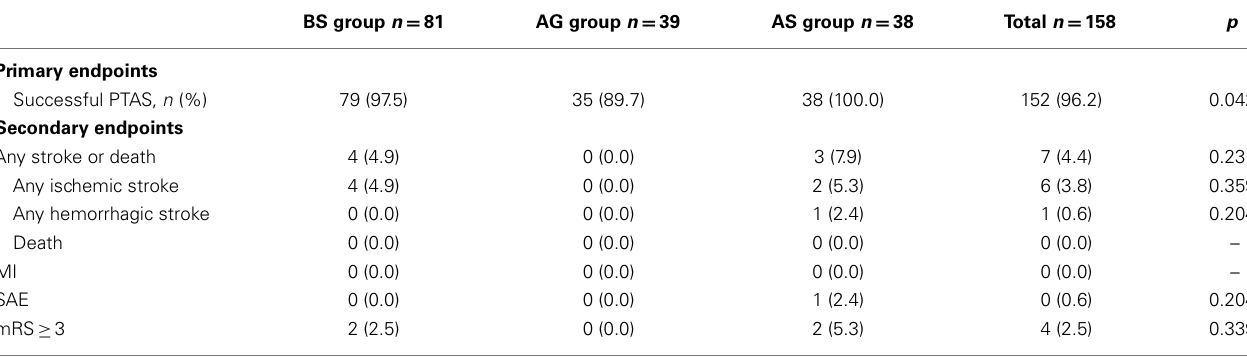
Table 1 |The efficacy endpoints of different therapy groups